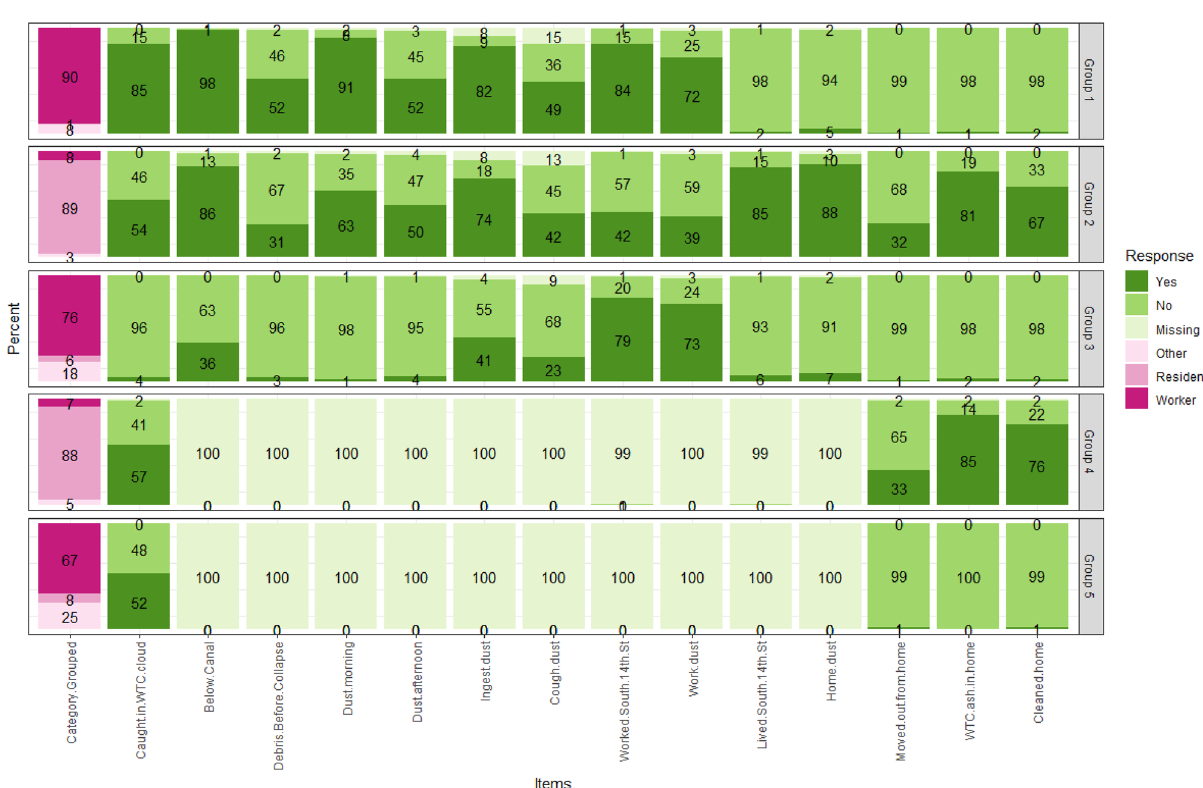
Figure 2. Latent class analysis with five latent exposure groups. X-axis lists 15 exposure variables used in latent class analysis, and y-axis represents the percent of exposure categories in each latent group. The analysis was based on 3605 patients. Five latent exposure groups were identified: 1348 (37.4%) local workers with acute and chronic exposures (Group 1); 789 (21.9%) local residents with acute and chronic exposures (Group 2); 516 (14.3%) local workers with chronic exposures (Group 3); 247 (6.9%) local residents with unknown acute exposures but high home exposure risks (Group 4); and 705 (19.6%) mixed patients with unknown acute exposures and low home exposure risks (Group